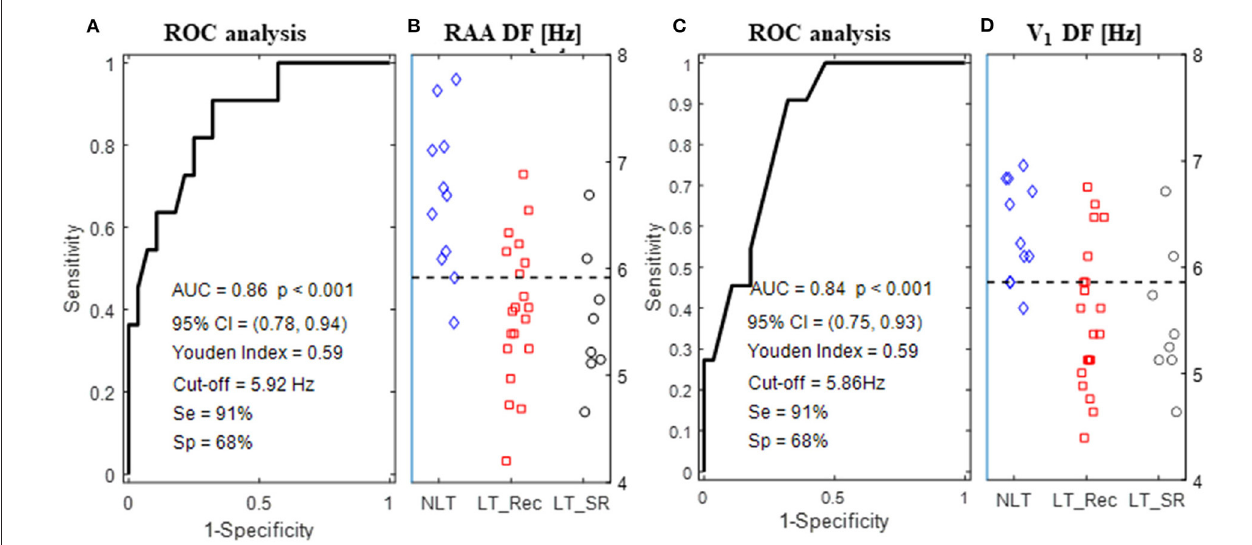
FIGURE 2 | ROC curve for baseline DF computed from the RAA (A) and lead V 1 (C) . (B,D) Show the distribution of RAA and V 1 DF values, respectively, grouped by the procedural outcome (NLT, LT_Rec, and LT_SR). The horizontal dashed lines indicate the optimal cutoff points for DF above which both procedural AF termination and SR maintenance at follow-up were less likely to be achieved by ablation. Abbreviations as in Table 3